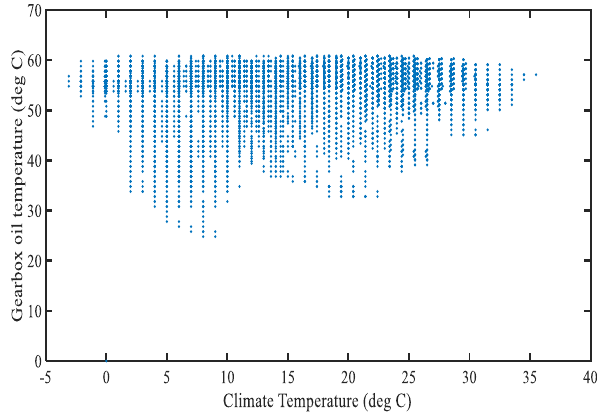
Table 1. The accuracy of the prediction models considering different input parameters. RMES: root mean square error.